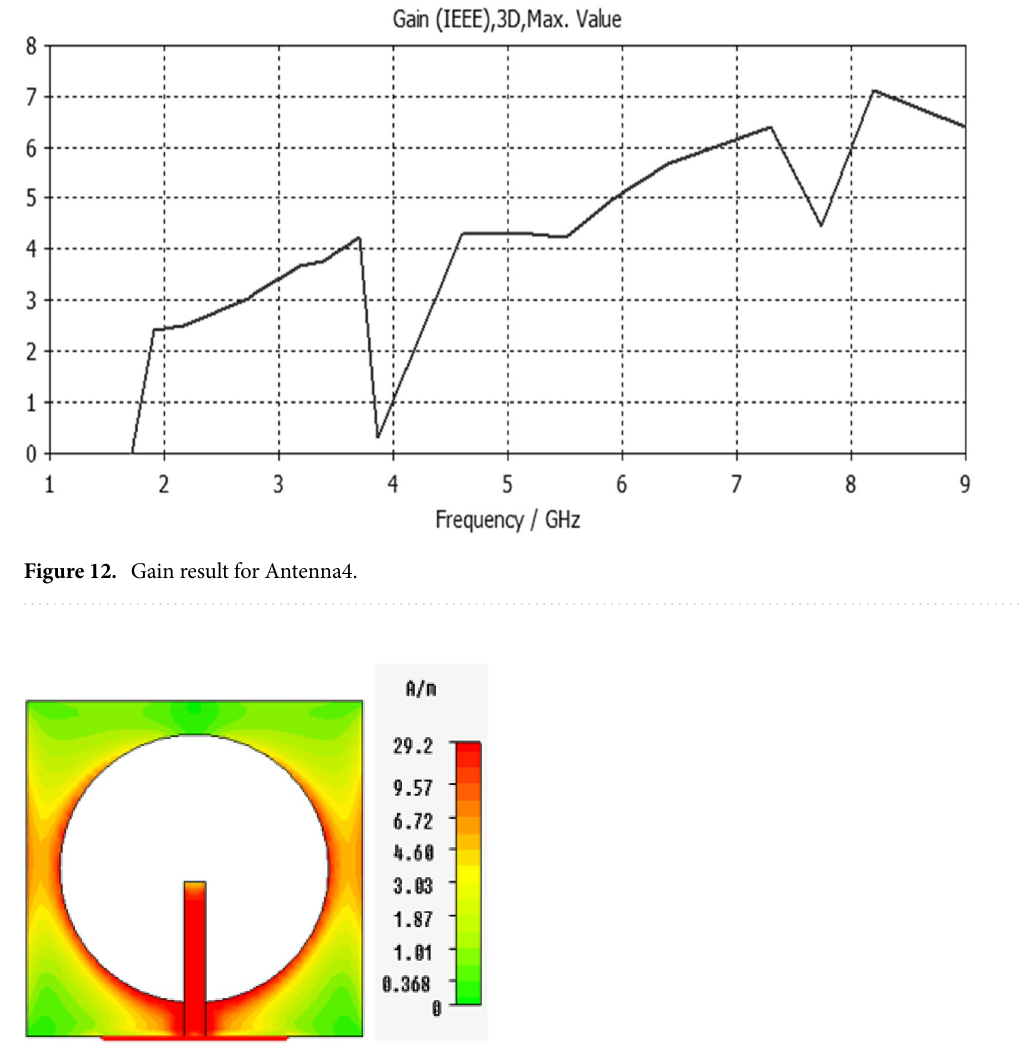
Figure 13. Magnetic intensity distributions for Antenna1 at the fundamental resonance of 2.7 GHz.